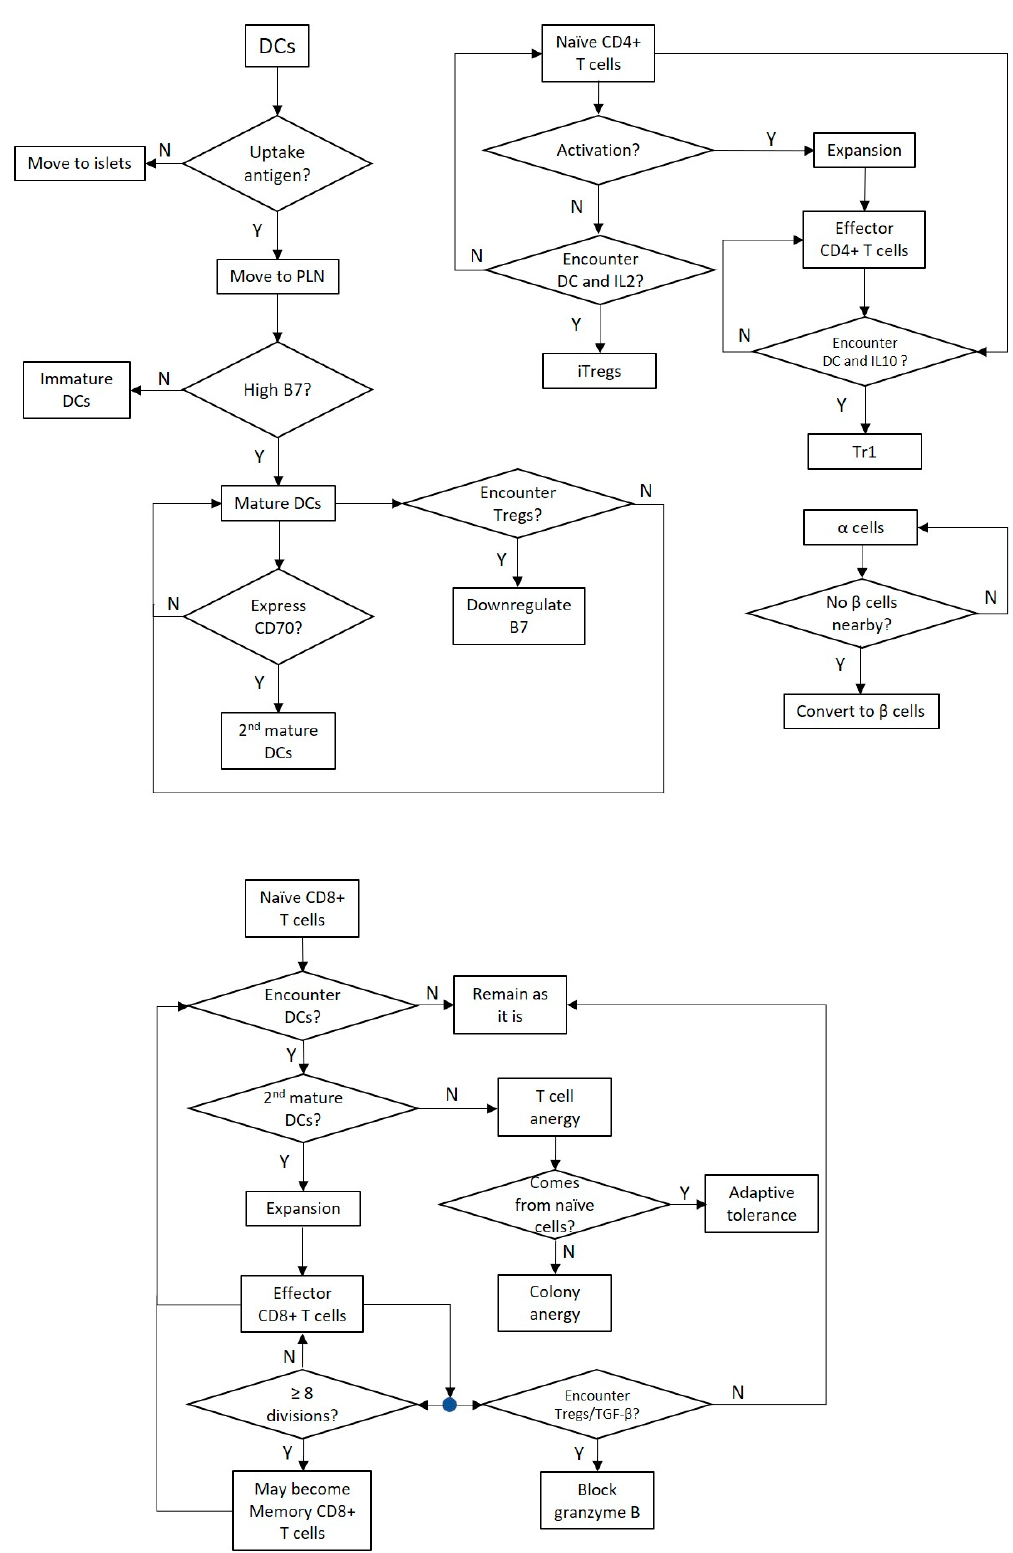
Figure 3. The flow chart of cell agent behaviors.